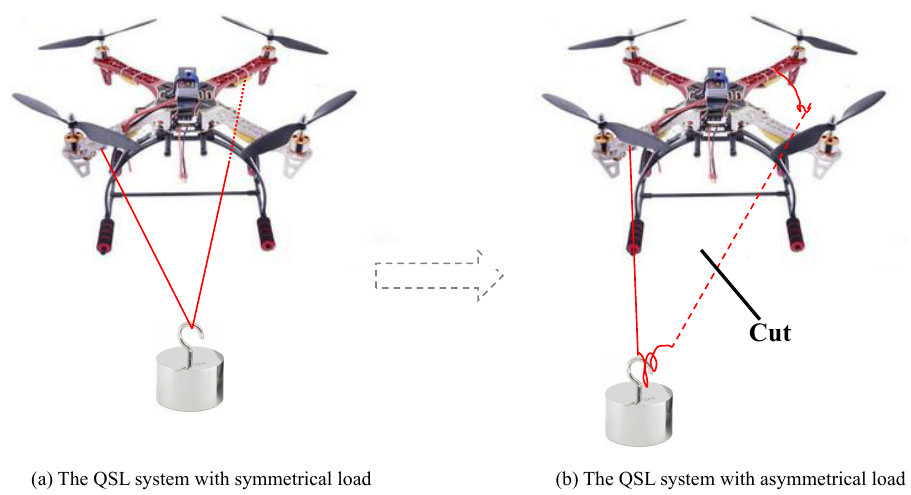
Figure 3. The experimental scenario. ( a ) The quadrotor slung load (QSL) system with symmetrical load; ( b ) The QSL system with asymmetrical